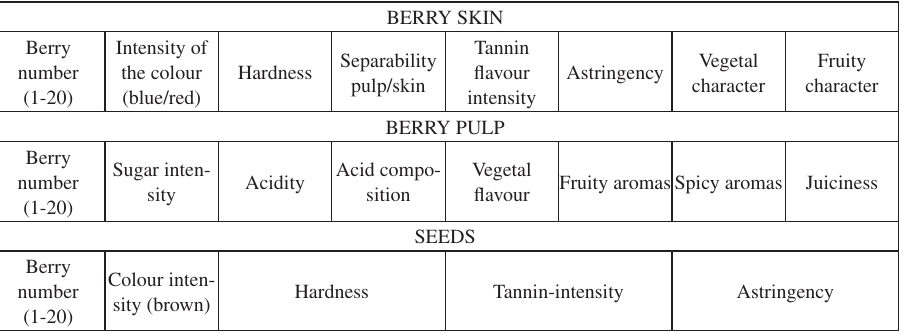
Table 2: Evaluation form for berry sensorial